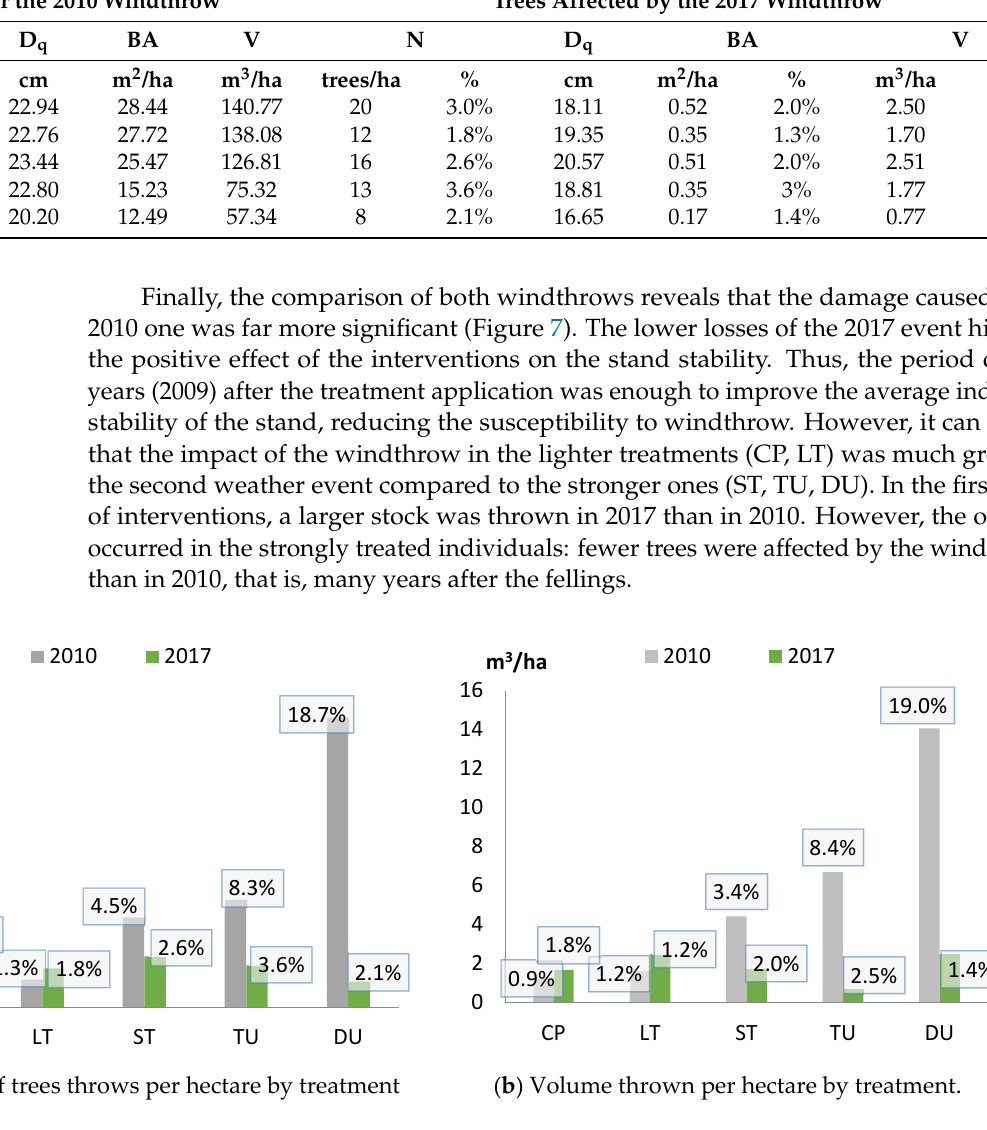
Table 4. Main parameters of the research plots by treatment after the 2010 windthrow and trees affected by the 2017 windthrow.